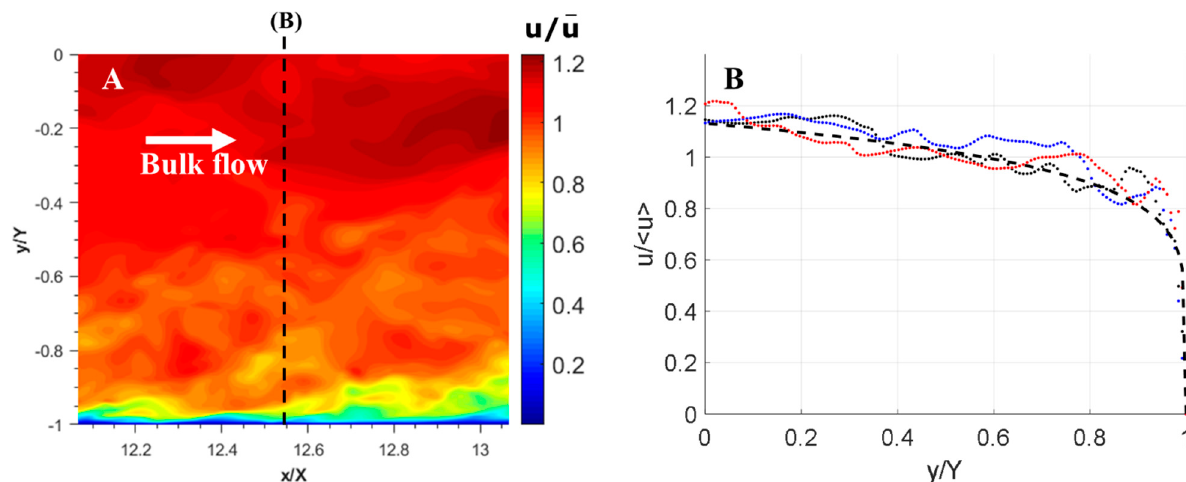
Figure 3. Illustration of the instantaneous flow in a channel with developed turbulence; ( A ) velocity magnitude of instantaneous stream ‐ wise velocities in a subsection of the channel (wall at y = − 1, y = 0 represents the center axis); ( B ) stream ‐ wise velocity profiles in the channel, showing the instantaneous velocities at three randomly chosen points in time (black, red and blue dots) and the time ‐ averaged velocity according to Prandtl’s 1/7th power law (dashed line).